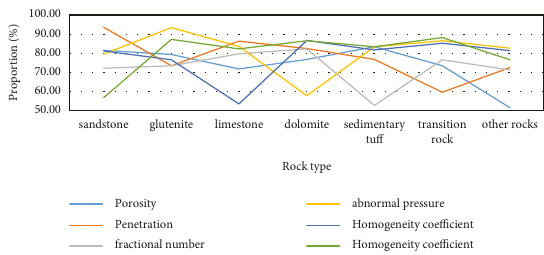
Figure 9: Comparison and analysis of different reservoir char- acteristics under